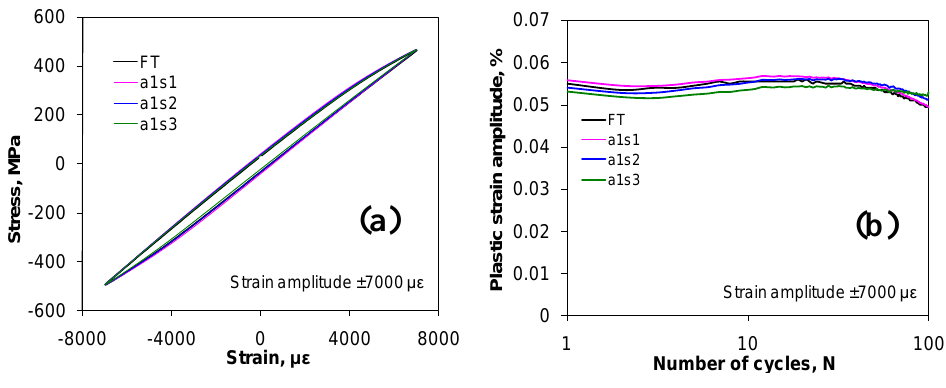
Figure 4. (a) FBG sensors measured stress as a function of applied strain at the 10th cycle at ±7,000 με strain amplitudes. (b) Plastic strain amplitudes of three sensors at ±7,000 με strain amplitude from the 1st cycle to the 100th cycle. (FT-represents extensometer data, a1s1- refers to Sensor 1 of Array 1 data, so are for a1s2 and a1s3).